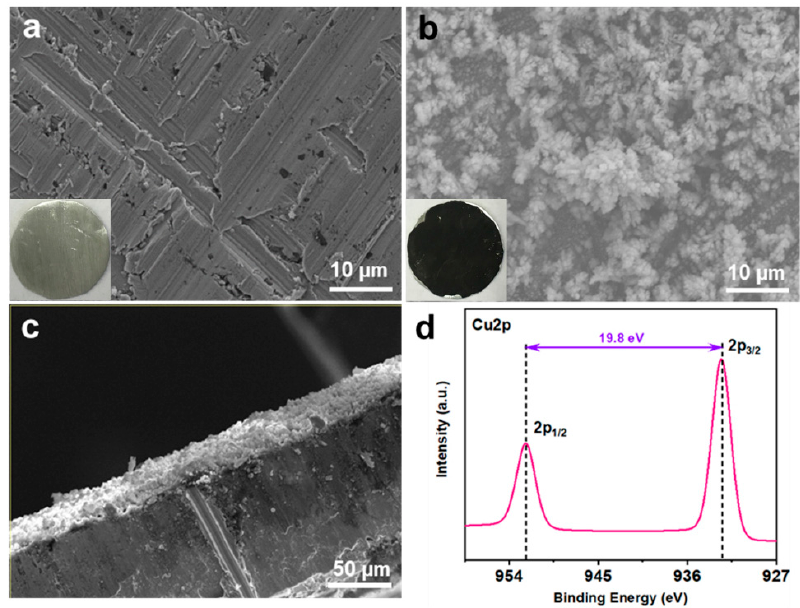
Figure 1. SEM images and optical images (insets) of ( a ) bare Zn foil and ( b ) Cu–Zn foil, ( c ) cross- section SEM images of Cu–Zn foil, ( d ) high resolution Cu 2p XP spectrum measured on Cu–Zn foil.